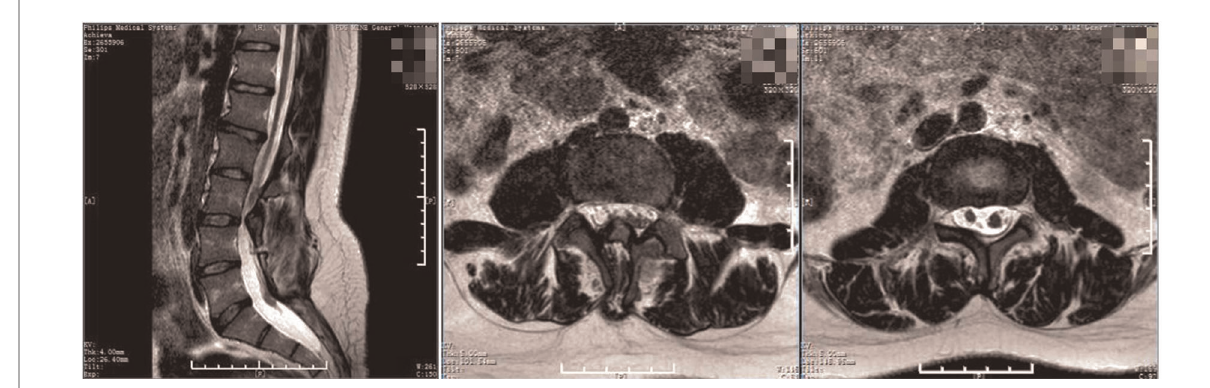
FIGURE 1 Preoperative MRI. The spinal cord was shifted down, approximately at L4 segment, with bifurcation of the lower part. The lamina of L3 segment was not fused, and the spinous process protruded into the spinal canal, resulting in spinal stenosis of the related